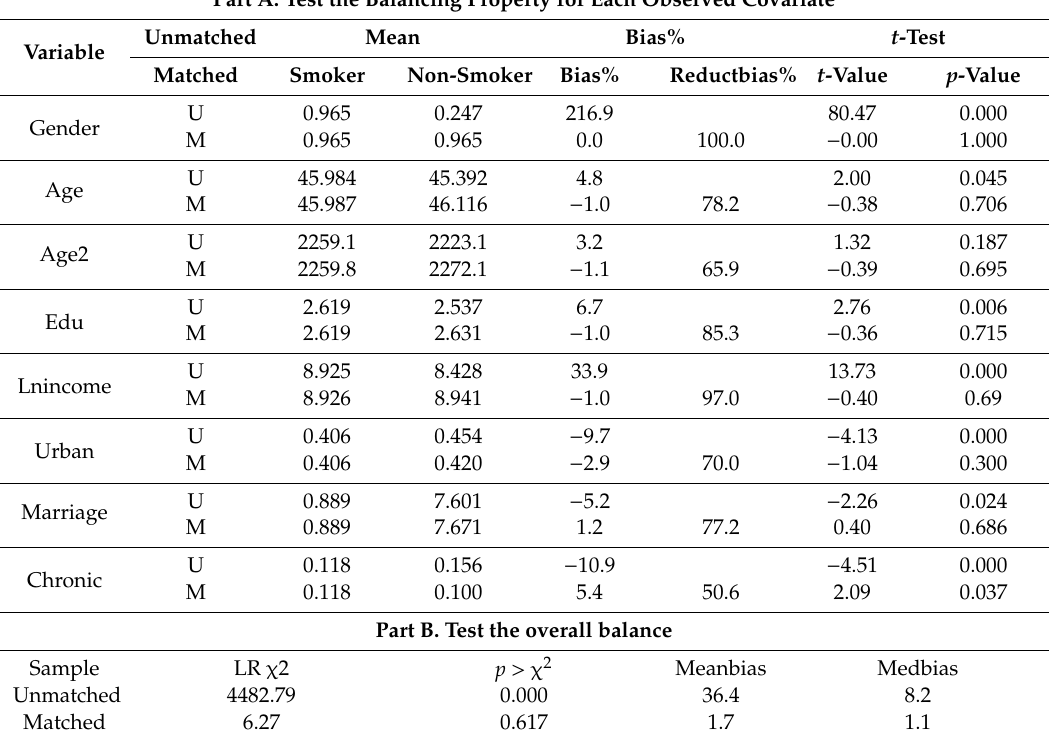
Table 2. Balancing tests from neighbor